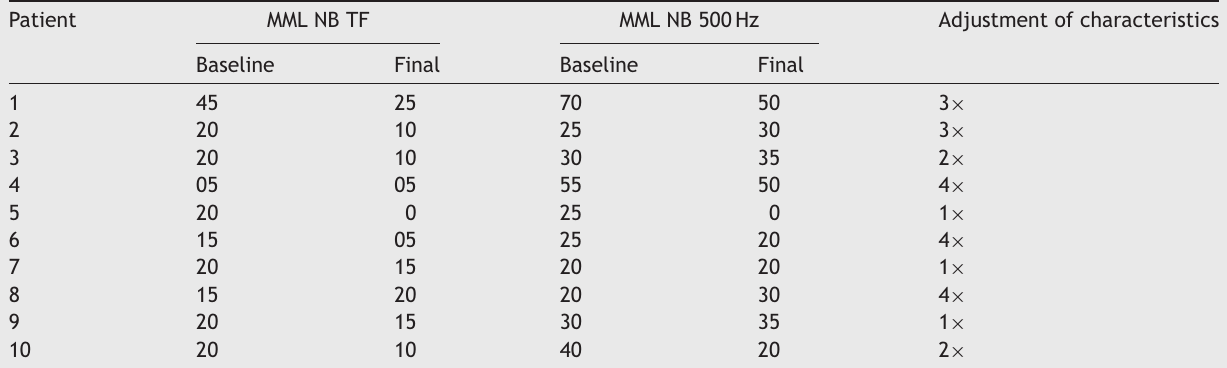
Baseline and final volume (dB) of minimum masking levels (MML) with narrow band (NB) at tinnitus frequency and at 500 Hz in sensation level, and the number of times that changes were made to generator